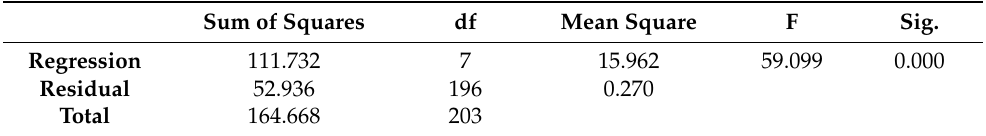
Table 6. Results of the ANOVA analysis.